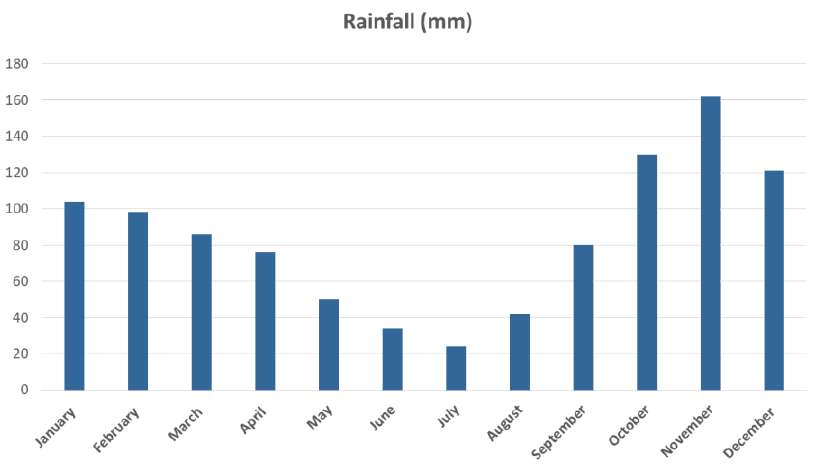
Figure 5. Annual solar radiation for the city of Portici (near Naples, Southern Italy).